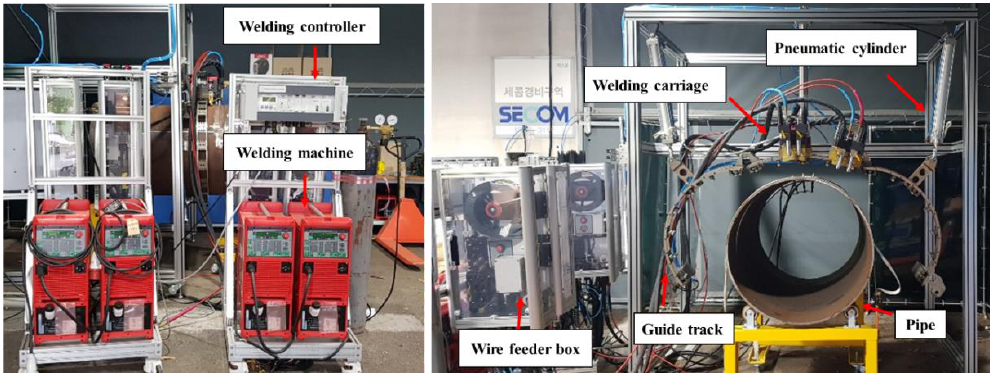
Figure 1. Integrated pipe lay systems: ( a ) S-lay system and ( b ) J-lay system.